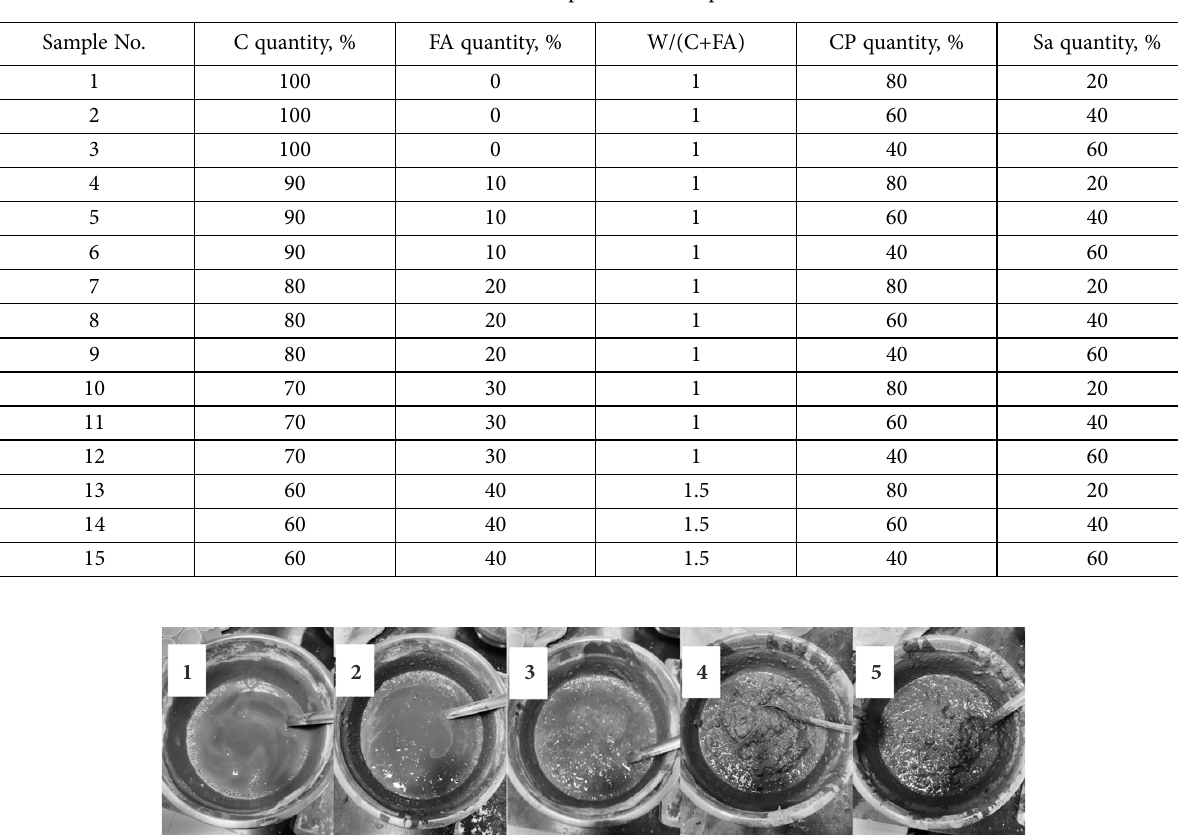
Table 3. Composition of samples